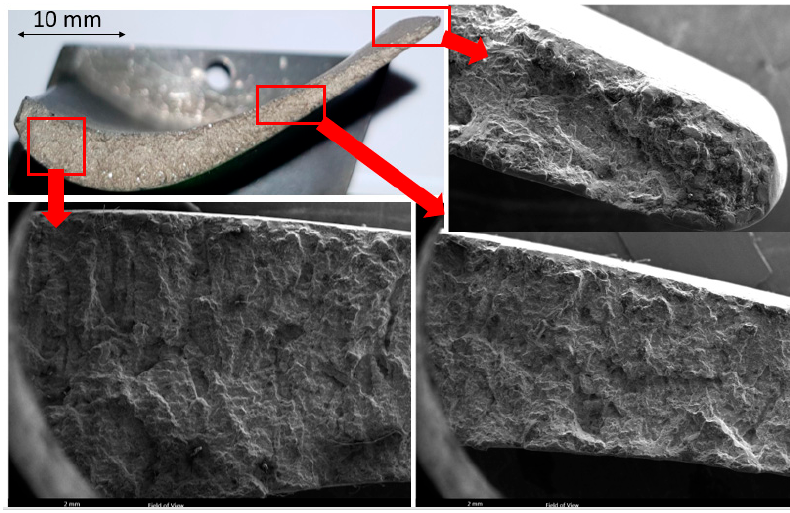
Figure 6. Images of fracture surface of the blade, broken from the airfoil.